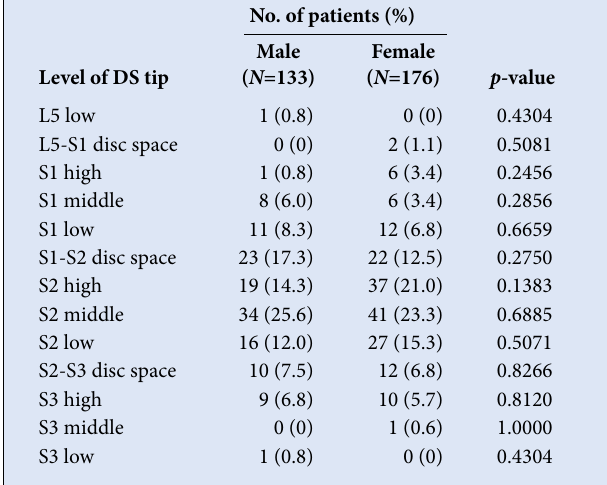
Table II. Comparison of DS tip levels by